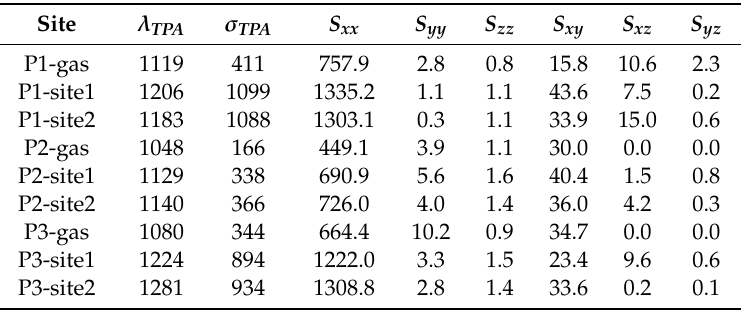
Table 3. The maximum two-photon absorption (TPA) wavelength λ TPA (nm), TPA cross-section σ TPA (GM, 1 GM = 10 − 50 cm 4 · s / photon), and the corresponding two-photon transition matrix element S αβ for P1, P2, and P3 in di ff erent microenvironments. Site λ TPA